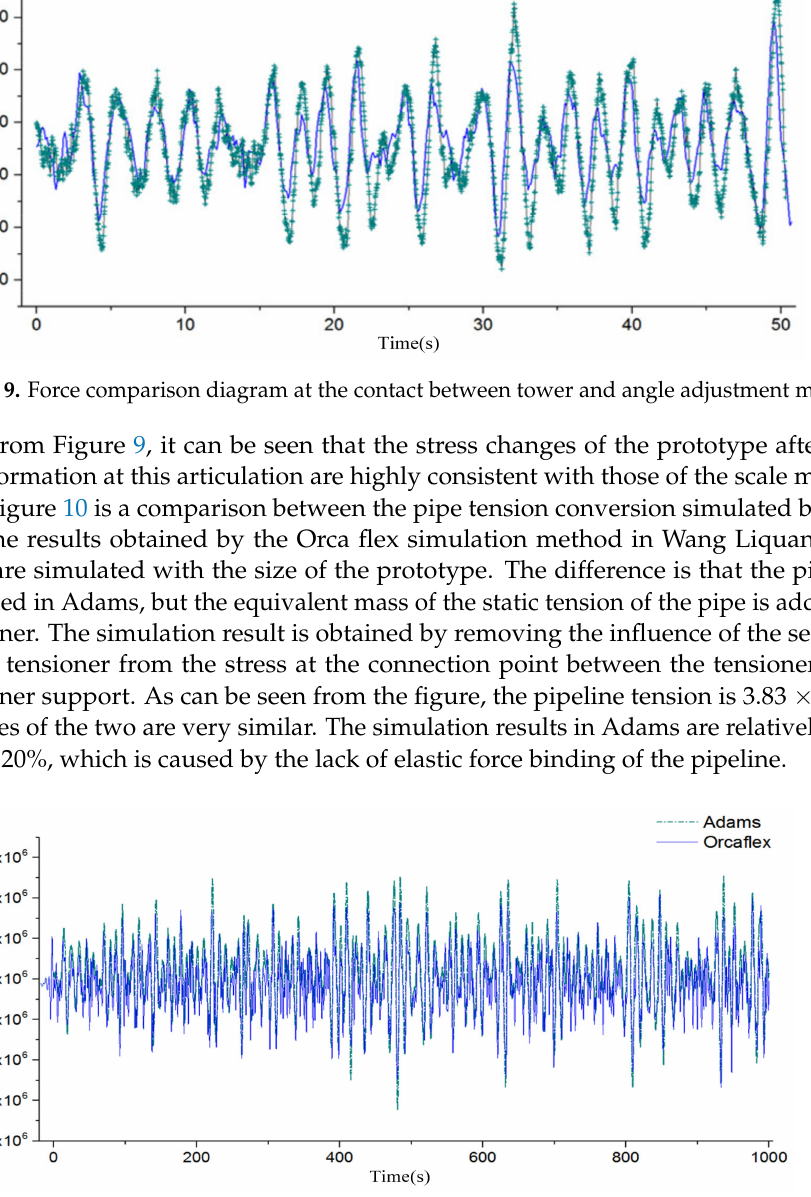
Figure 10. Comparison of pipe tension changes simulated by Adams and